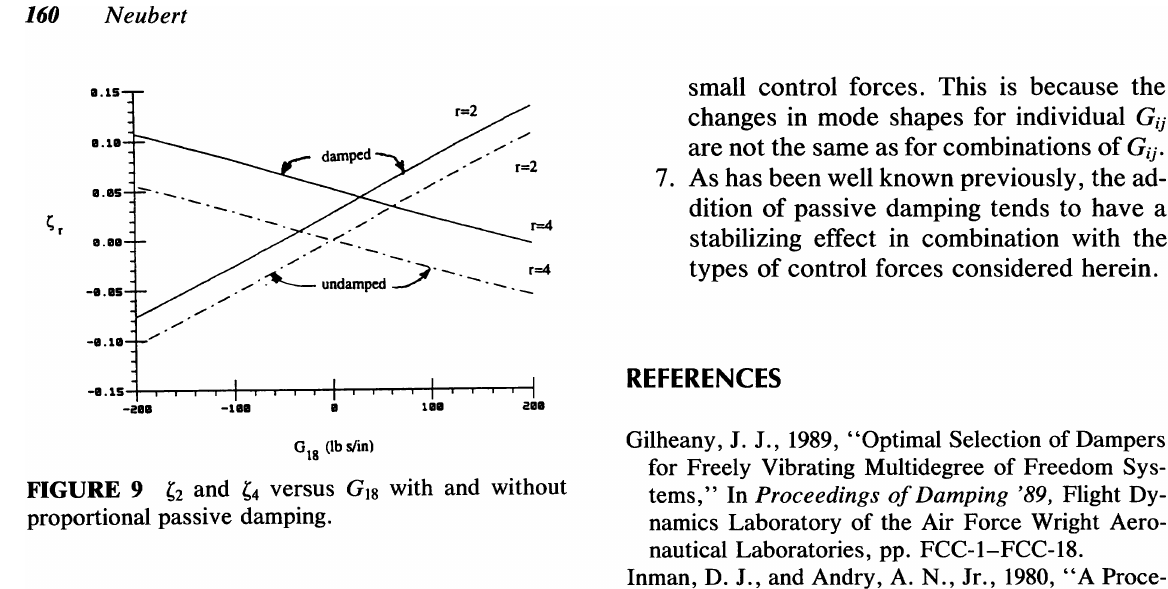
FIGURE 9 ~2 and ~4 versus GIS with and without proportional passive